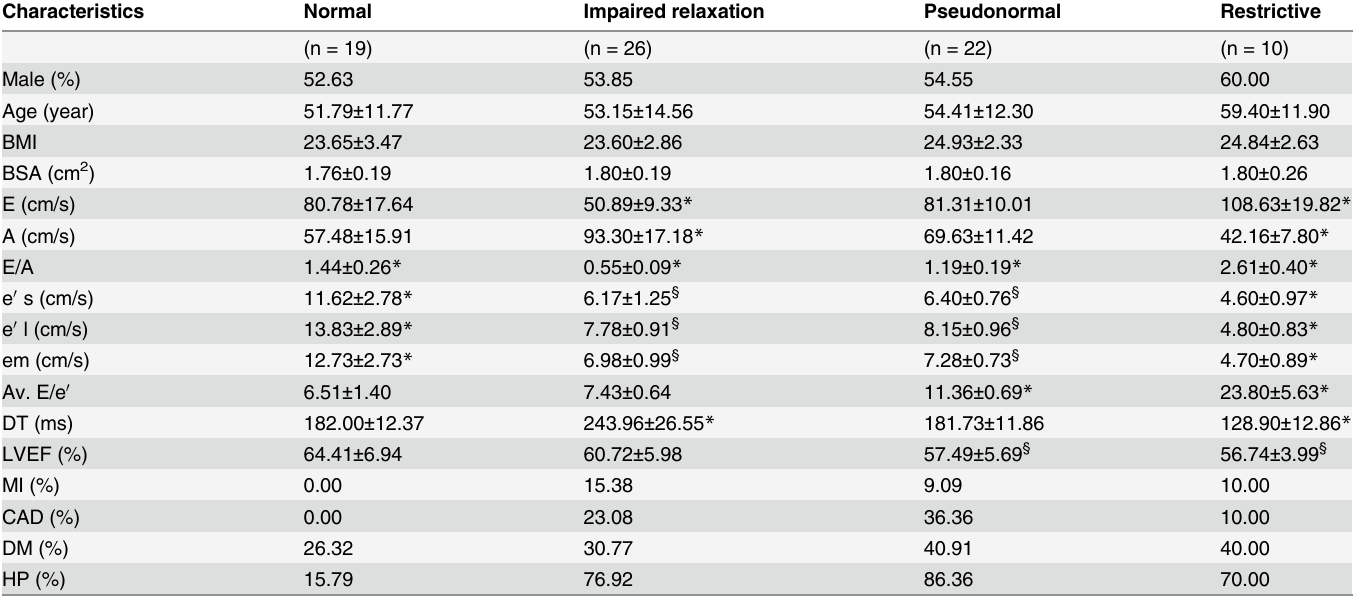
Table 1. Clinical characteristics and echocardiographic variables of the normal group and LV diastolic dysfunction groups. Characteristics